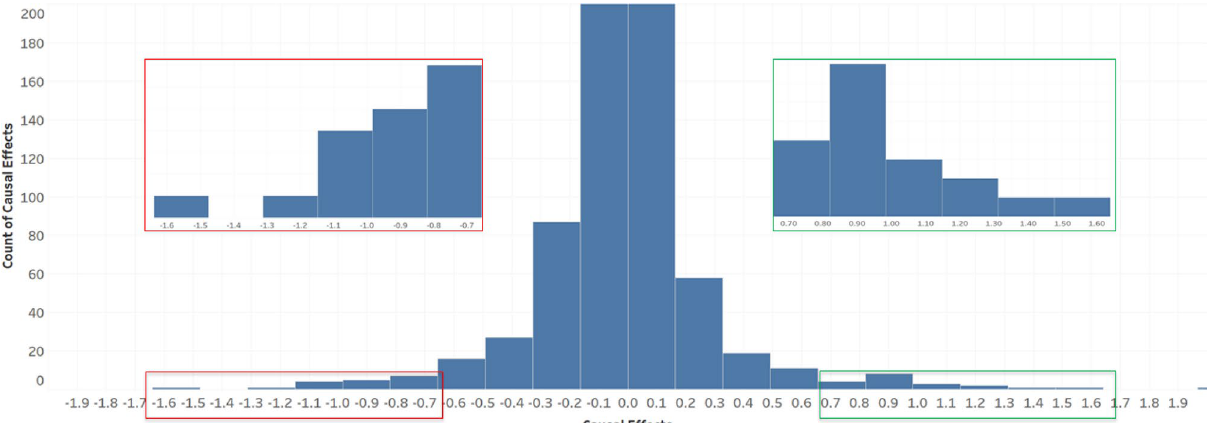
Figure 6. Histogram of pairwise causal effect values in the UC network. The top (green) and bottom (red) 15% are zoomed in for details.